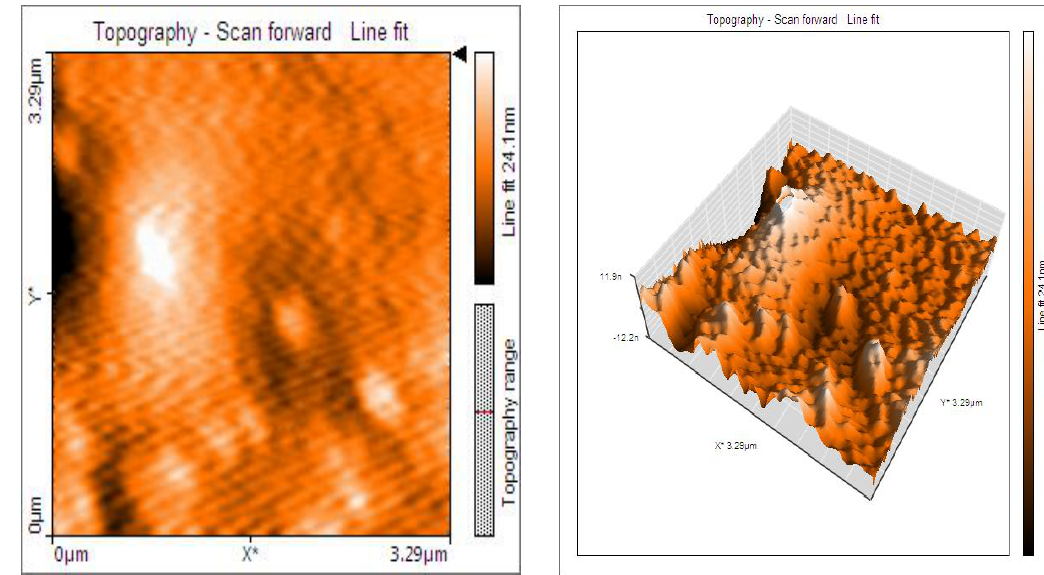
Fig.4: The AFM images of synthesized